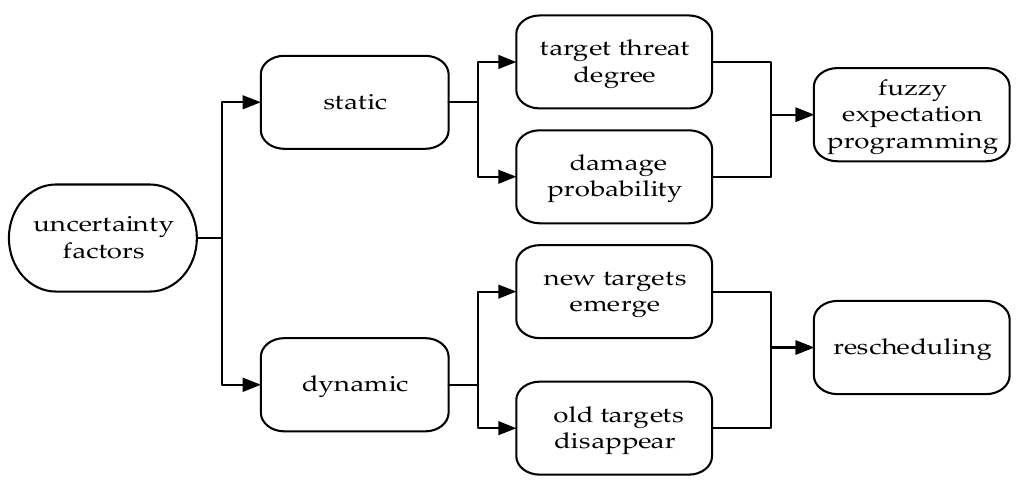
Figure 1. Uncertainty factor classification diagram.